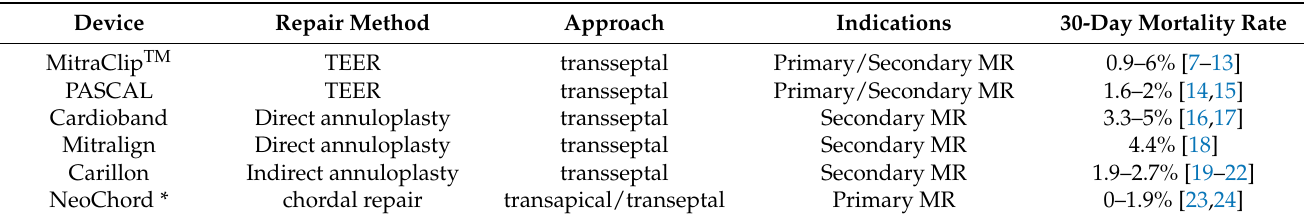
Table 1. Overview of Transcatheter Mitral Valve Repair Device Features.